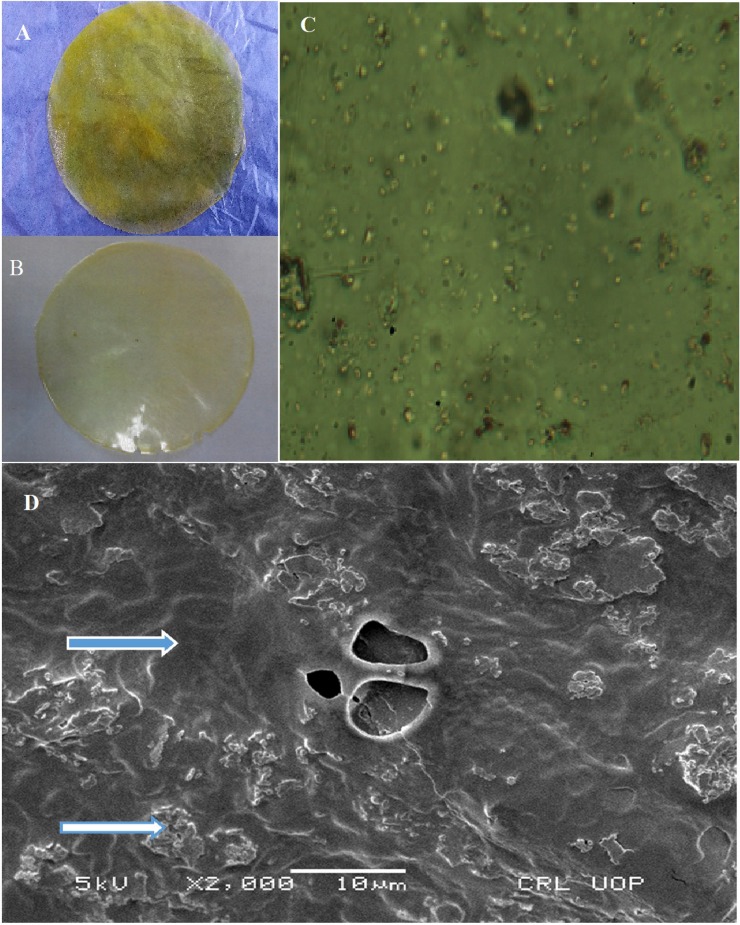
Image taken by the digital camera (Nikon Coolpix p500) showing shiny and smooth surface of the SR layer of TZN (A) and IR layer of MLX (B), Optical microscopic image of bilayer buccal film taken by an optical microscope at 40X (C) and SEM image of bilayer buccal film taken at 2000X (D) showing uniform mixing of ingredients (blue arrow with white outline is indicating polymeric meshwork while white arrow with blue outline is pointing out the imbedded drug).